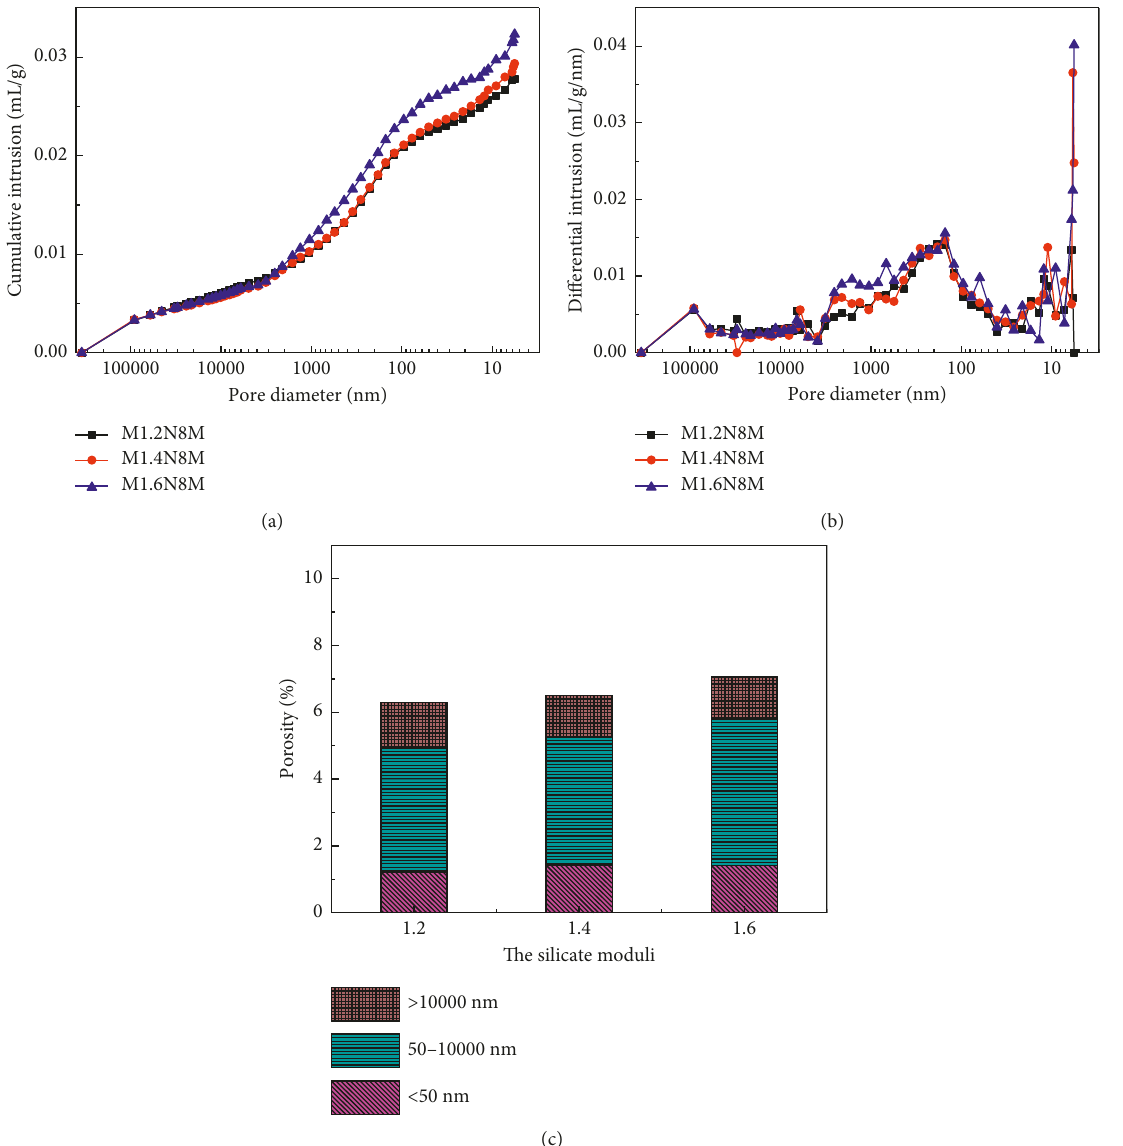
Figure 12: The pore size distribution of AAS mortars with different silicate moduli: (a) cumulative intrusion curves; (b) differential intrusion curves; (c)